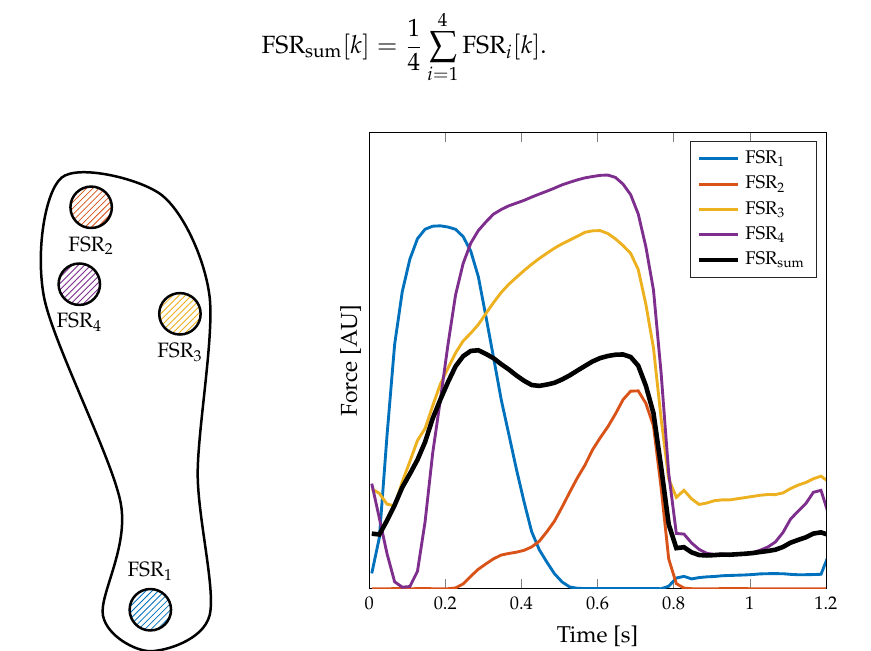
Figure 4. Implementation of the force sensing resistor (FSR) insole. ( a ) The insole is equipped with four FSR402 sensor pads located at the distal phalanges (FSR 2 ), the first (FSR 4 ) and the fifth metatarsophalangeal joints (FSR 3 ), and the heel (FSR 1 ). ( b ) An exemplary measurement of a step with this sensor setup. Note that the FSR sum does not reflect the actual force, since the setup is not calibrated to the individual pressure distribution.